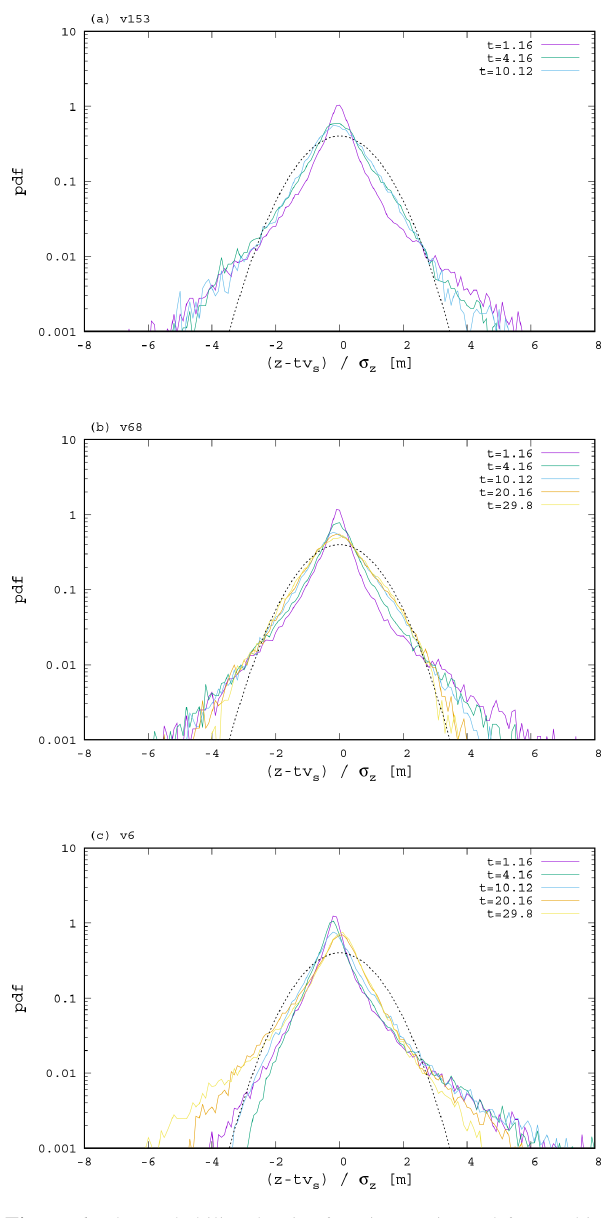
Figure 6. The probability density function, estimated from a his- togram of bin size 0 . 1, of all particles released in the Mediterranean for the different setups (v153, in the rescaled variable ˜ z = z − tv s σ z v68 and v6) and times (in days) as indicated. For comparison, nor- mal distributions of zero mean and unit variance are shown with a dashed